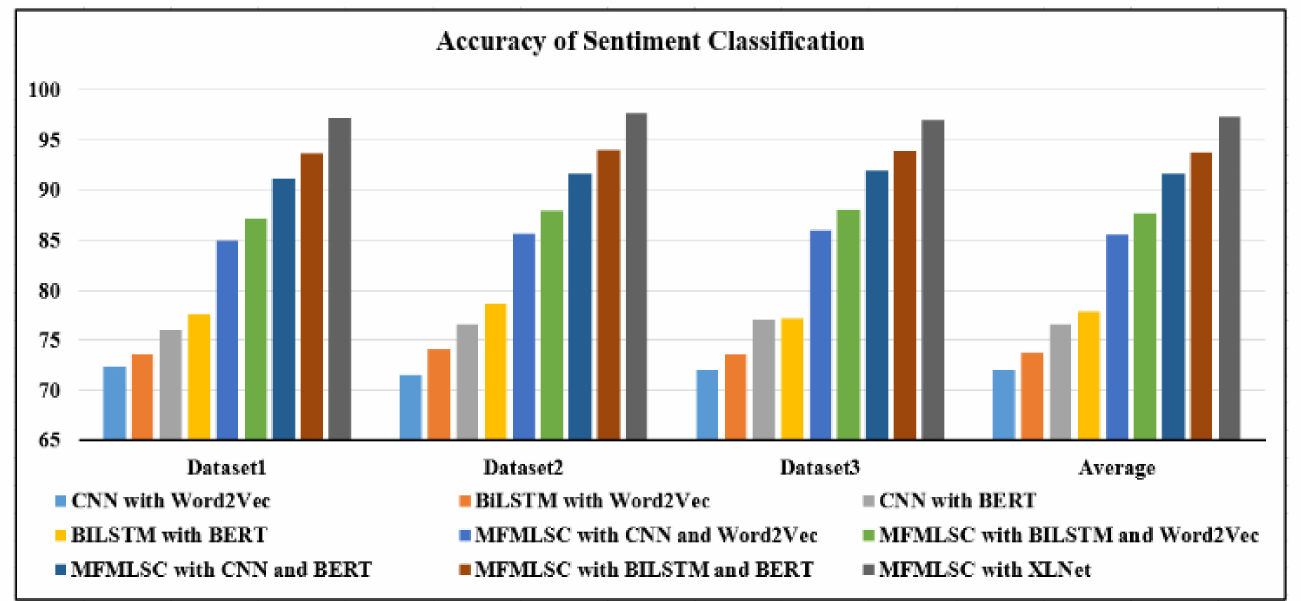
Figure 7. Graphical representation of the performance with the